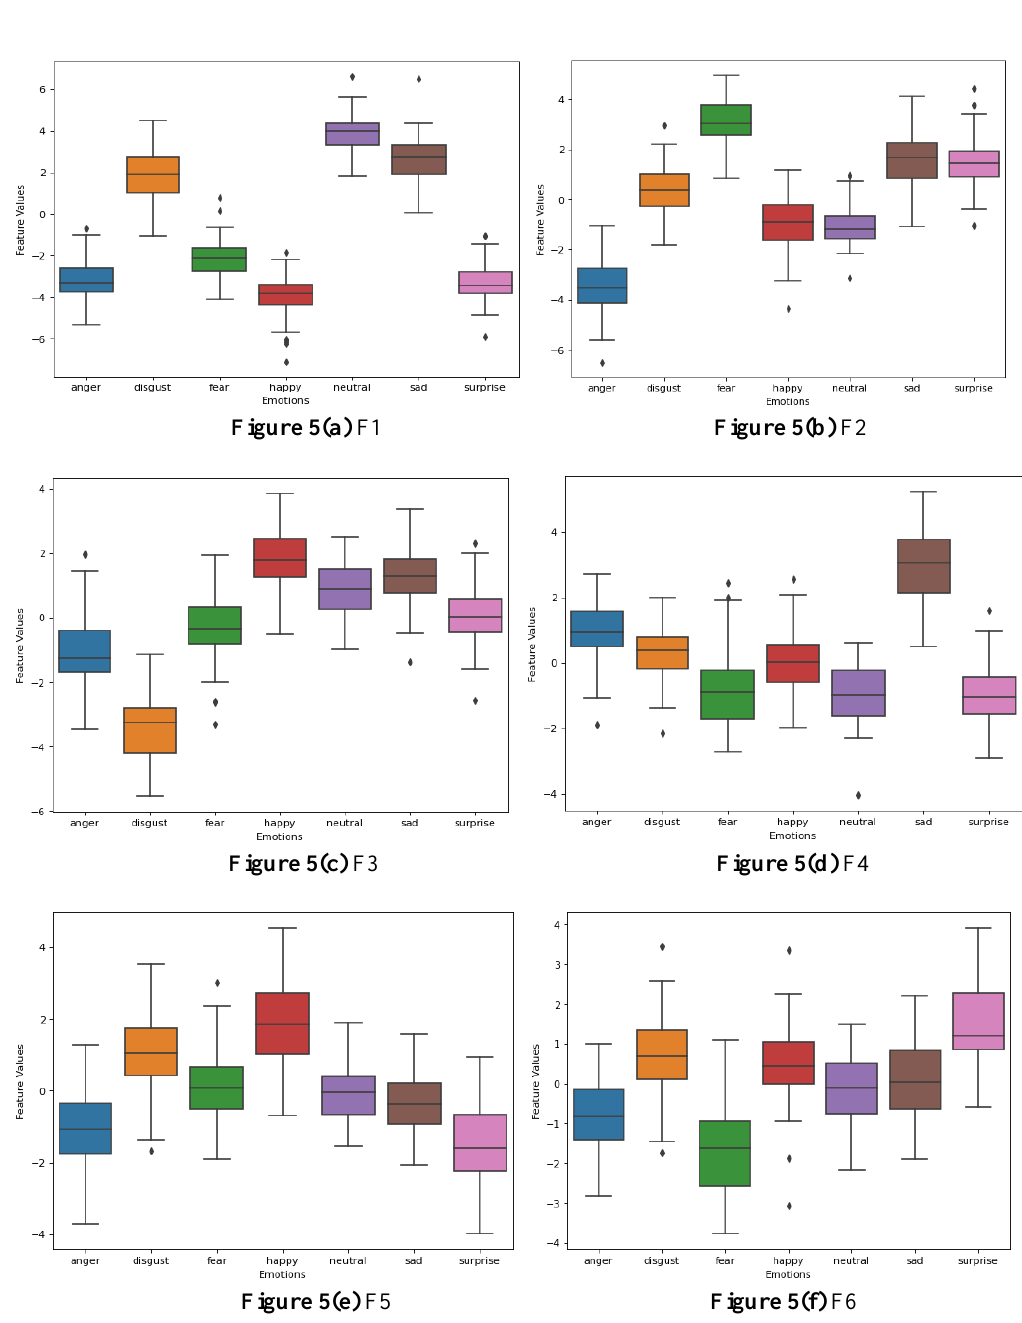
Figure 5. Box-plot of S-LDA features for 7